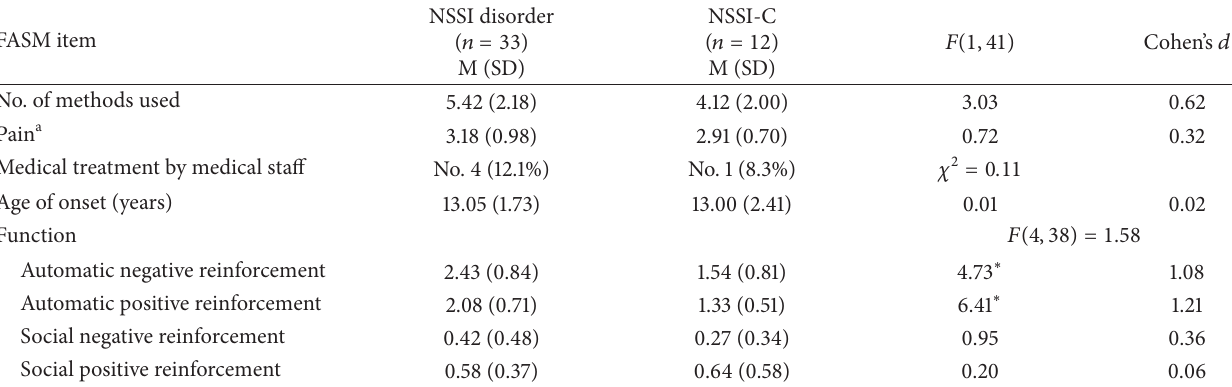
Table4:Means,standarddeviations(SDs),andeffectsizes(Cohen’s 𝑑 )oftheFASM,inadolescentswithNSSI(NSSIdisorder)andadolescents with NSSI without impairment/distress